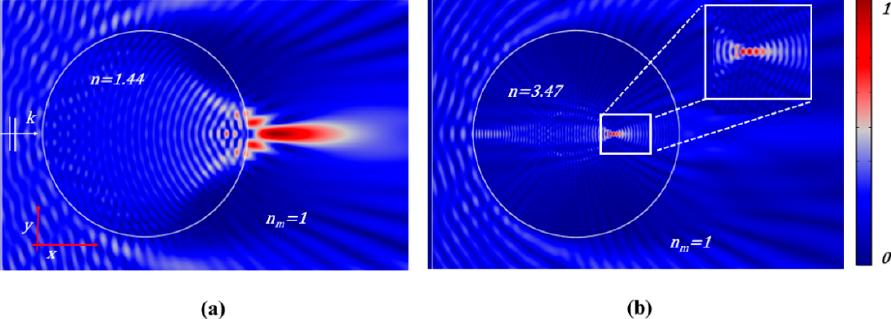
Figure 1. Normalized electric field intensity profile of PNJ in a silica microsphere ( n = 1.44) of radius 5 λ in vacuum ( a ) and PNJ of Si microsphere of same radius ( b ). Inset shows the close-up of PNJ in Si microsphere.